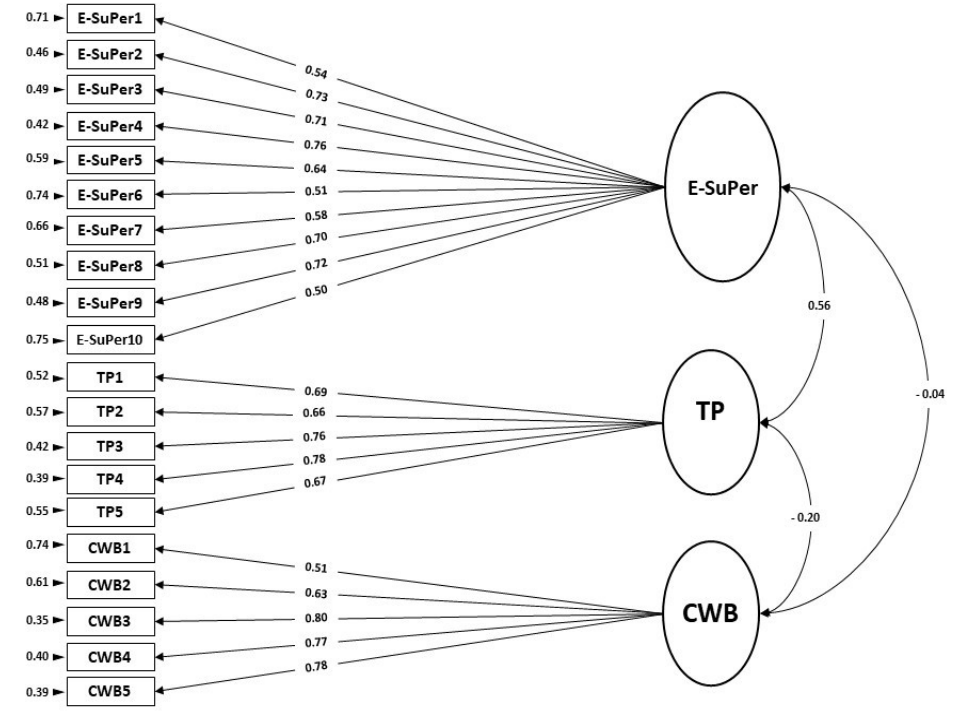
Figure 3. Path diagram and the coefficient for the three-factor CFA structure of E-SuPer–TP–CWB ( n = 160).